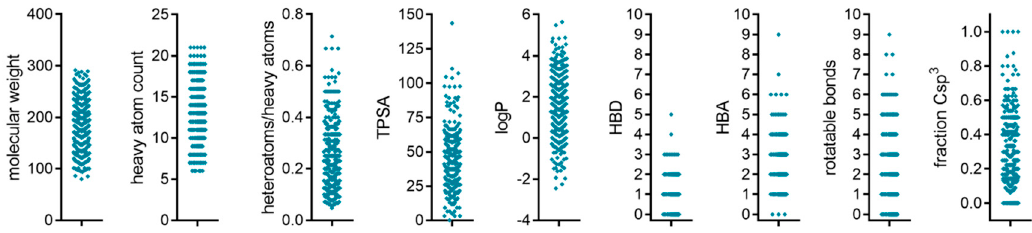
Figure 1. Characteristics and feature distribution of the fragment screening library. TPSA – topological polar surface area; HBD – H-bond donor; HBA – H-bond acceptor. polar surface area; HBD—H-bond donor; HBA—H-bond